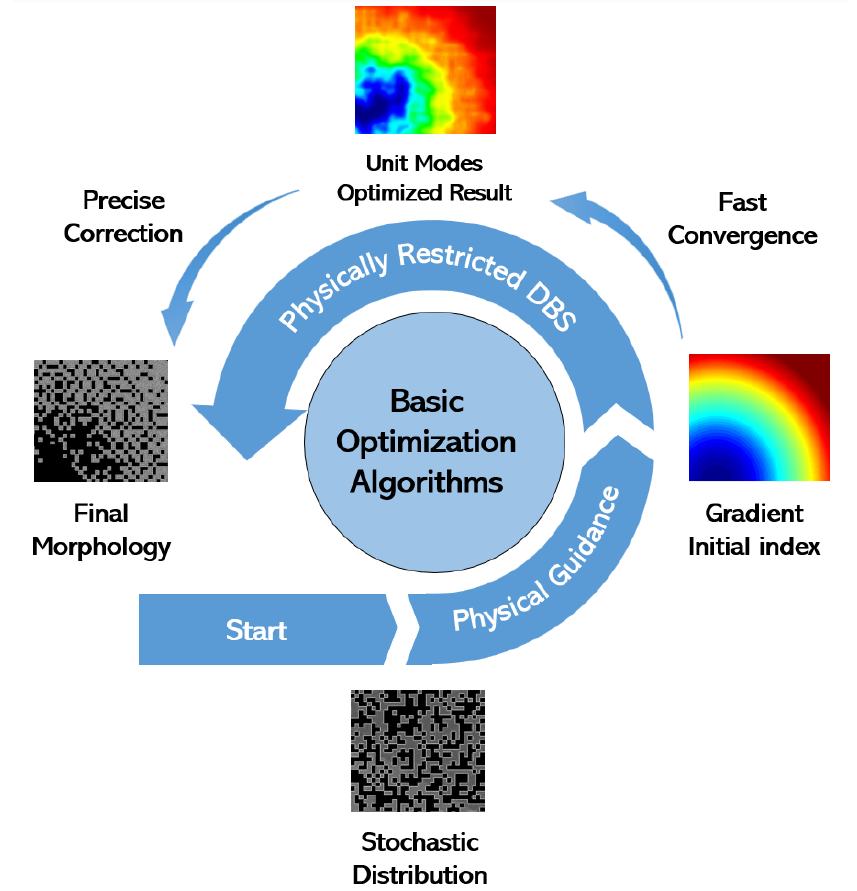
Figure 3. Design pipeline for the metasurface layer.